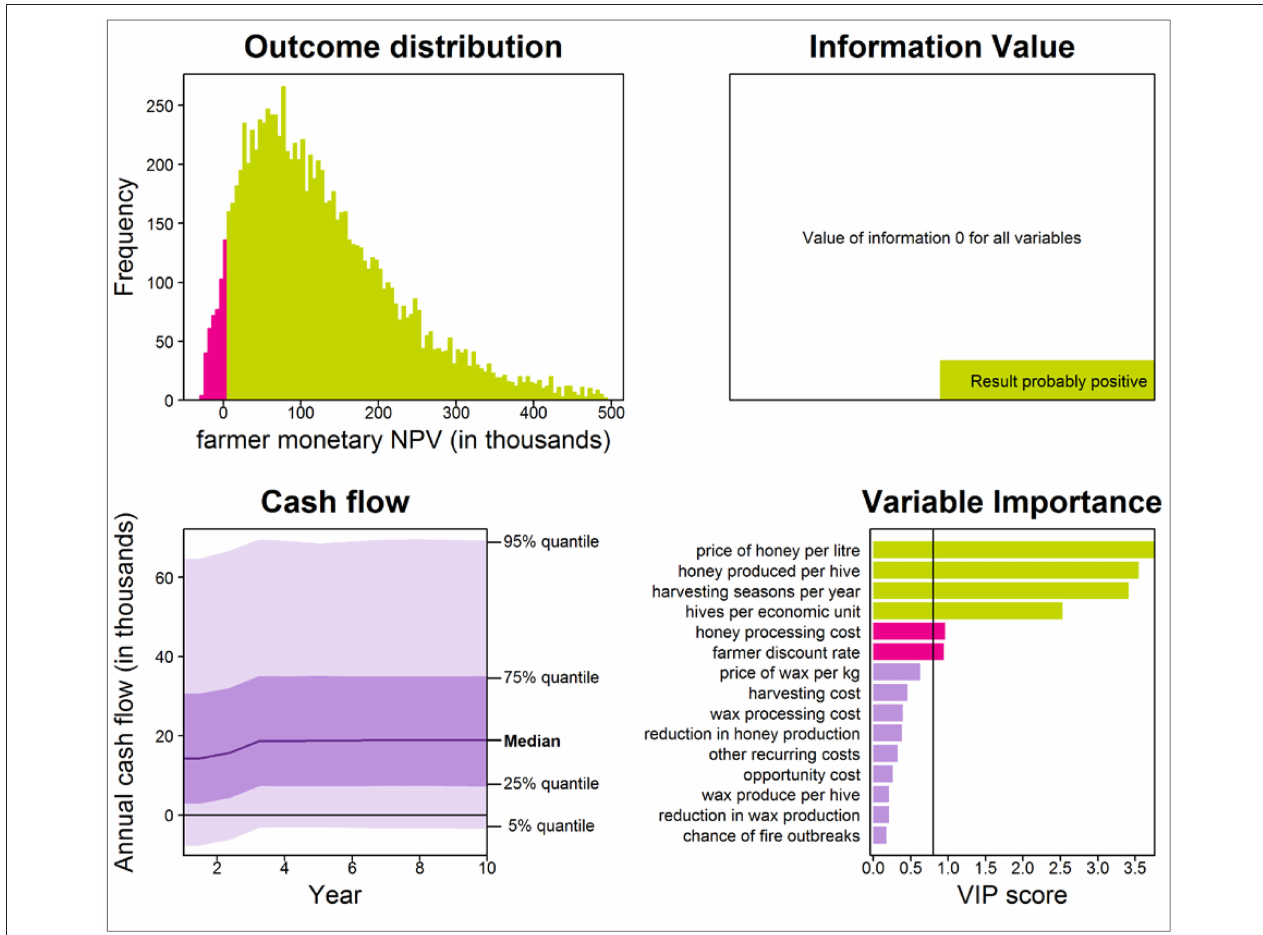
FIGURE 6 | Projected outcome distribution (top left), high-value variables (EVPI; top right), project cash flow (bottom left) and important variables (determined by PLS regression; bottom right) for a farmer practicing beekeeping in Awer, Kenya. Results were produced through Monte Carlo simulation (with 10,000 model runs) of project performance over 10 years. Red and green bars in the outcome distribution indicate positive and negative values, respectively. In the PLS plot, green bars indicate positive correlations of uncertain variables with the outcome variable, while red bars indicate negative